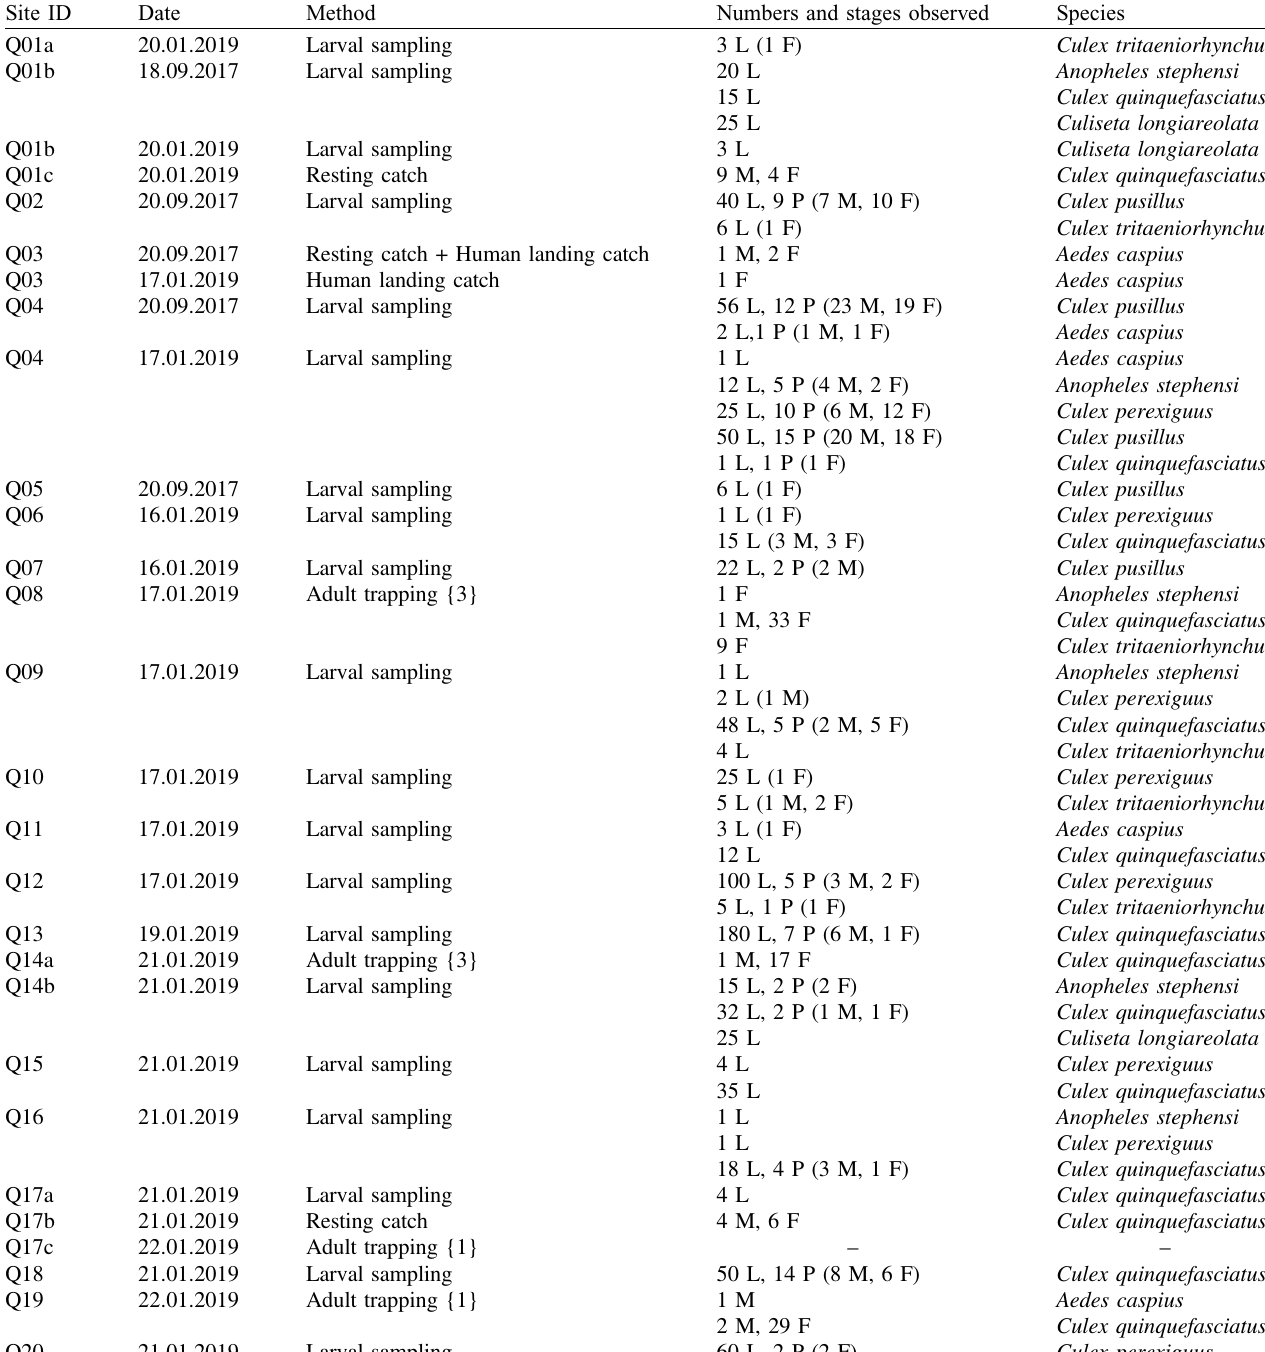
Table 4. Mosquito species observed during our sessions 2 and 3 fi eld surveys in Qatar, September 2017 and January 2019, per site. Within rounded parentheses: adults obtained by rearing of immatures; Within braces: number of traps. F = female; L = larva; M = male; P =